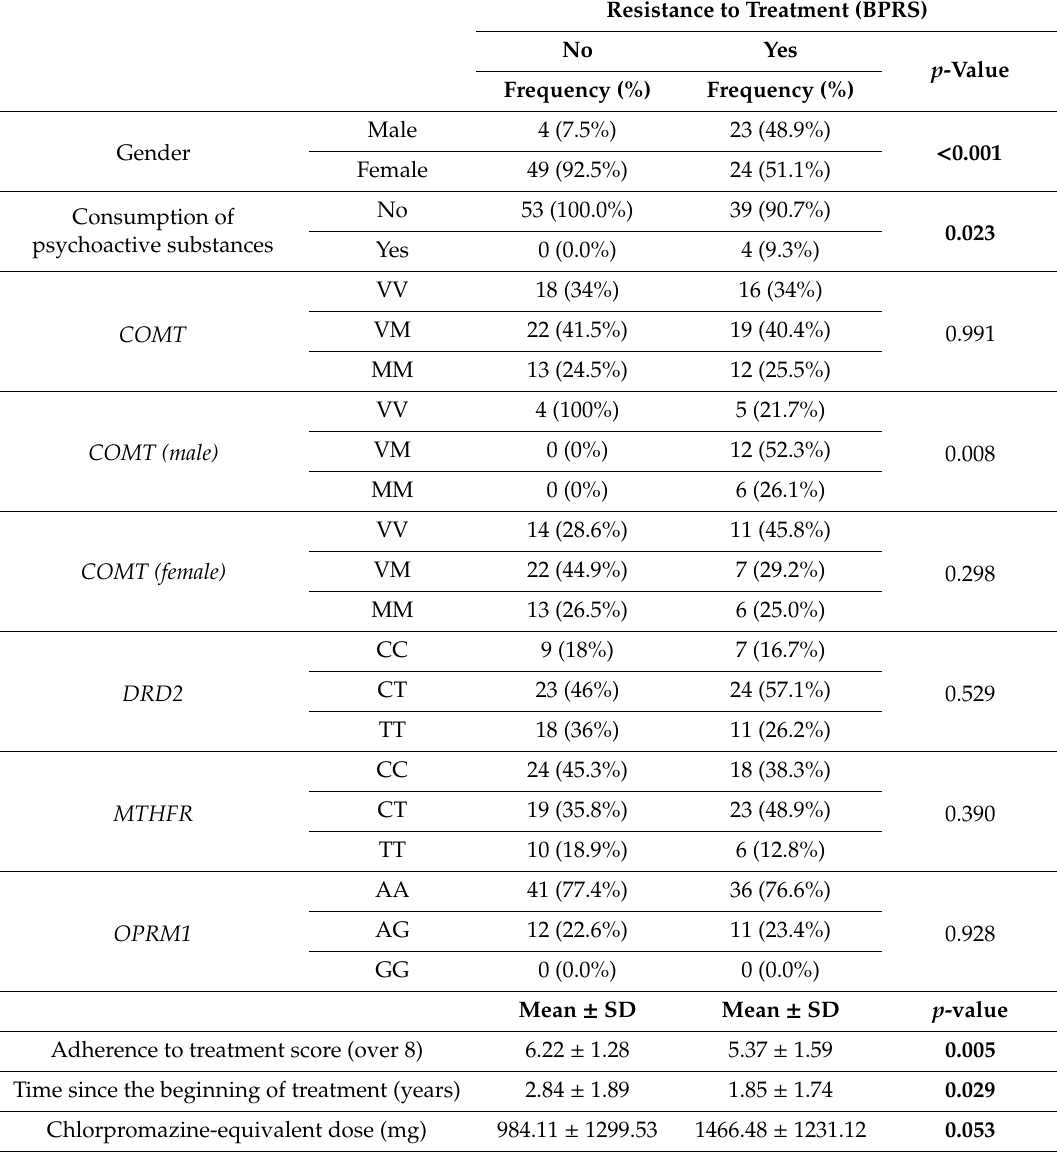
Table 3. Bivariate analysis taking the resistance to treatment, as evaluated by the BPRS scale, as the dependent